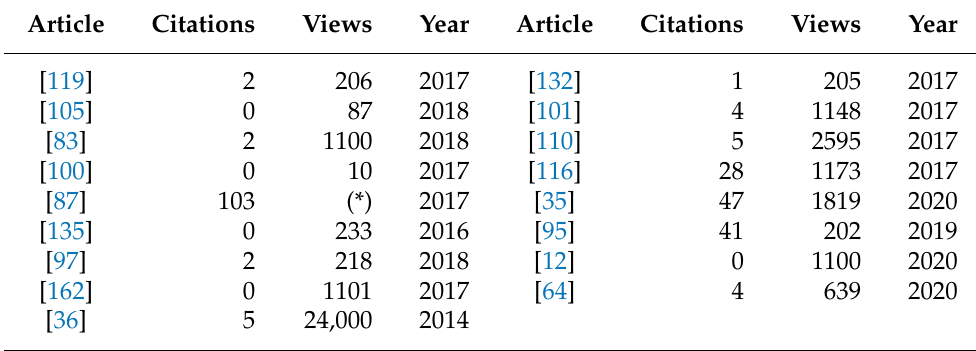
Table 6. Number of citations and readings to publications defining